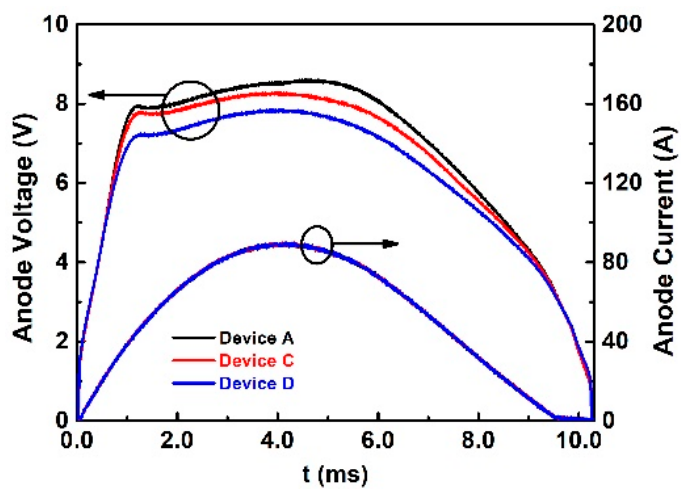
Figure 15. Surge waveforms of Device A, Device C, and Device D at surge current equal to 90 A.